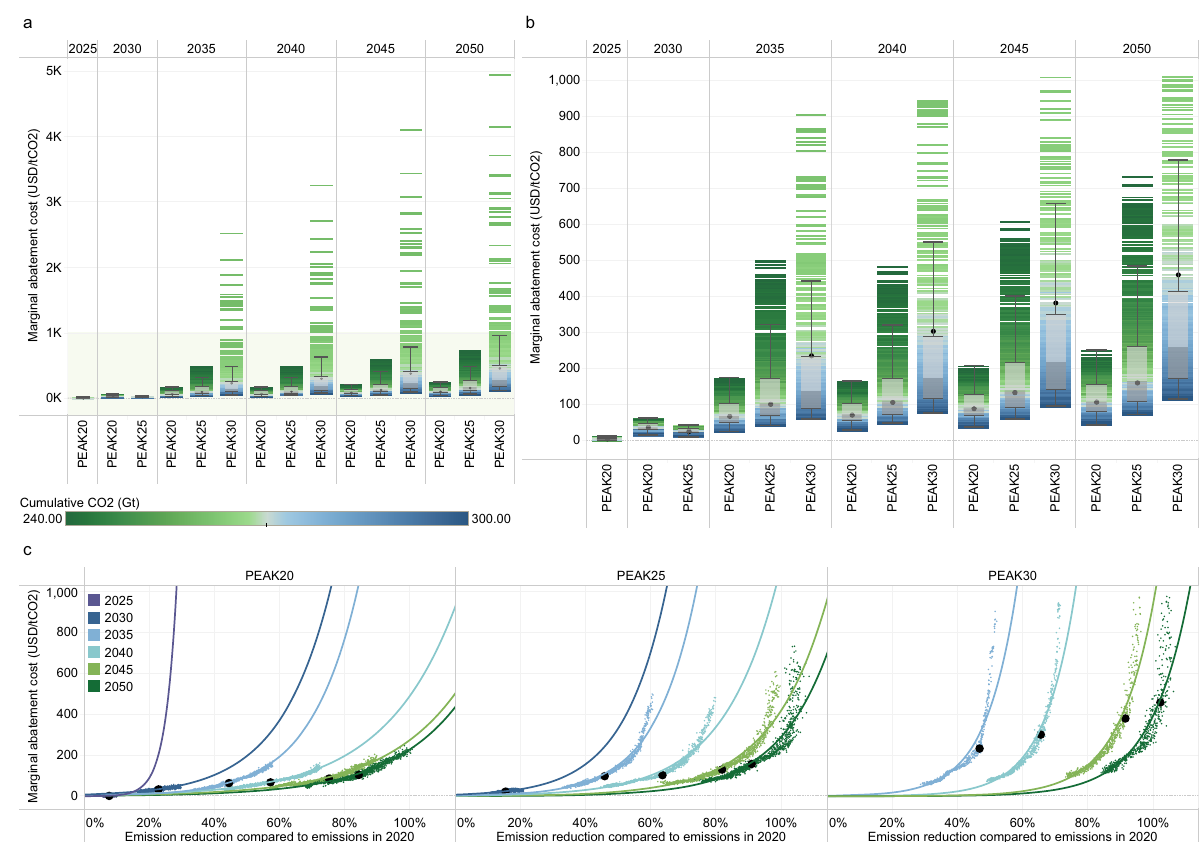
Fig. 9 Marginal abatement cost under different scenarios (unit: US dollars/tCO 2 ). a represents the marginal abatement cost of all feasible cases. b enlarges the concentrated data in panel a (green shadow) corresponding to all cases with carbon prices below 1,013 US dollars per ton CO 2 by 2050 (90% of the total feasible cases for PEAK30). c Relationship between the marginal abatement cost and the CO 2 emission reduction in reference to emissions in 2020 (as fi tted by an exponential function). The black points represent the marginal abatement costs for the intermediate cases in each scenario. The box plot shows the fi rst quantile, intermediate range (IQR), and third quantile of all the results, where the data range within 1.5 times the IQR is denoted with whiskers. The divergent color from blue to green re fl ects the increasing stringency of the cumulative carbon budget. The cumulative CO 2 parameter corresponds to the absolute value of China ’ s cumulative carbon budget for 2010 – 2050. Supplementary Fig. 18 shows the relationships between the marginal abatement cost and other uncertain